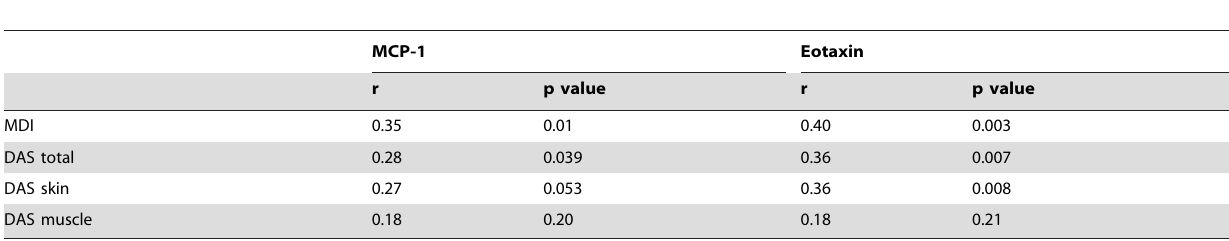
Table 4. Correlations between MCP-1, eotaxin and disease variables in patients with juvenile dermatomyositis 1 year post -